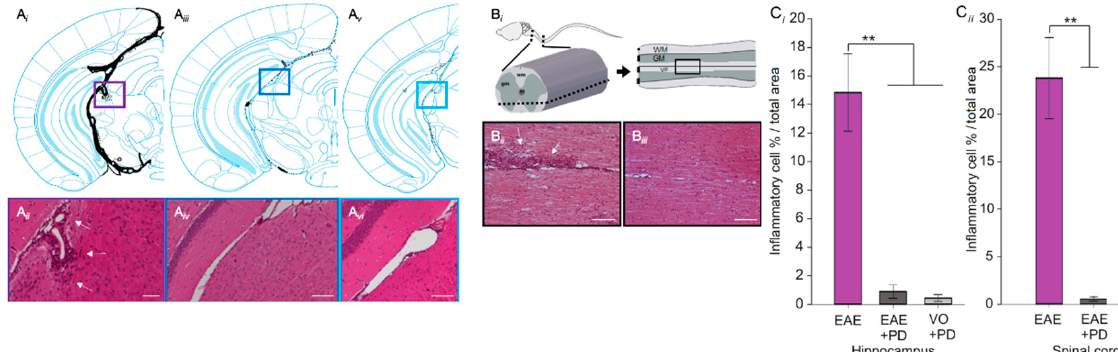
Figure 2. Effect of platelet depletion on inflammatory infiltration into the CNS. ( A ) shows representative H & E stained sections of the effect of platelet depletion in the hippocampus, with camera lucida images to map the lesion locations ( Ai , Aiii , Av ). Ai and Aii = EAE-induced/isotype control, Aiii and Aiv = EAE-induced/PD-treated, Av and Avi = VO/PD-treated. ( B ) shows representative images of the spinal cord, with Bi = region of interest, Bii = EAE-induced/isotype control, Biii = EAE-induced/PD-treated. Scale bar = 150 µ m. ( C ) Quantification of inflammation was performed on n = 4 mice/group × 4 sections/mouse, using ImageJ. Data are expressed as lesion area as a % of total area. EAE = experimental autoimmune encephalomyelitis, VO = vehicle only, PD = platelet depletion, WM = white matter, GM = grey matter, VF = ventral funiculus.